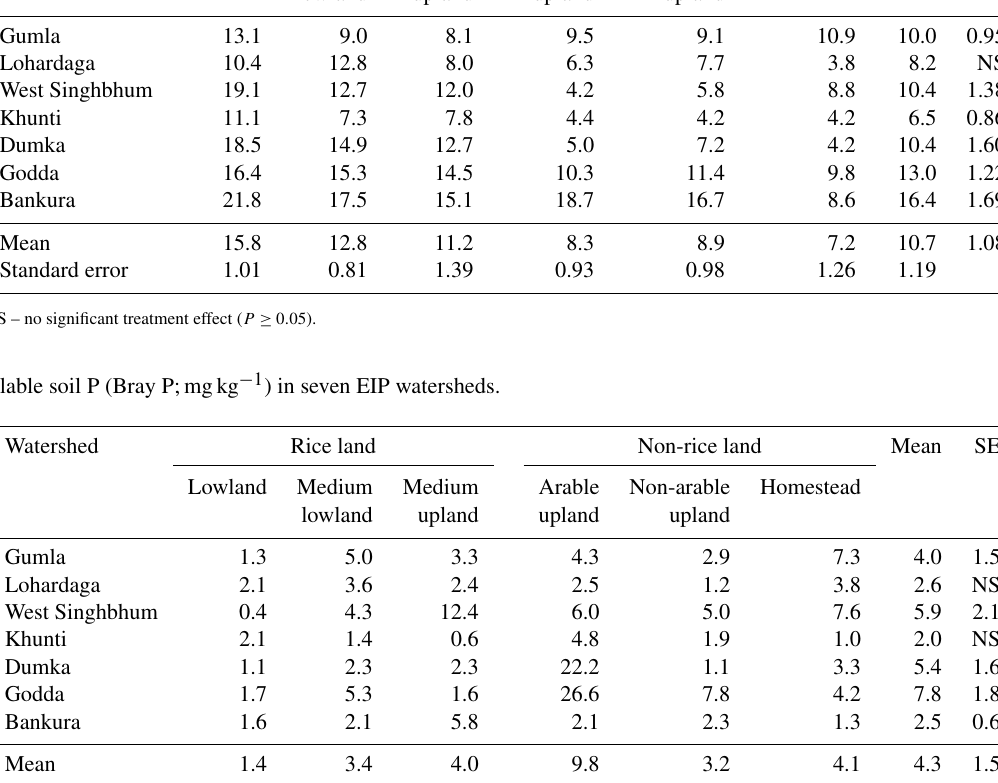
Table 3. Cation exchange capacity (cmol c kg − 1 ) of soils in seven EIP watersheds. Watershed Rice land Non-rice land Mean SE Lowland Medium Medium Arable Non-arable Homestead lowland upland upland upland Gumla